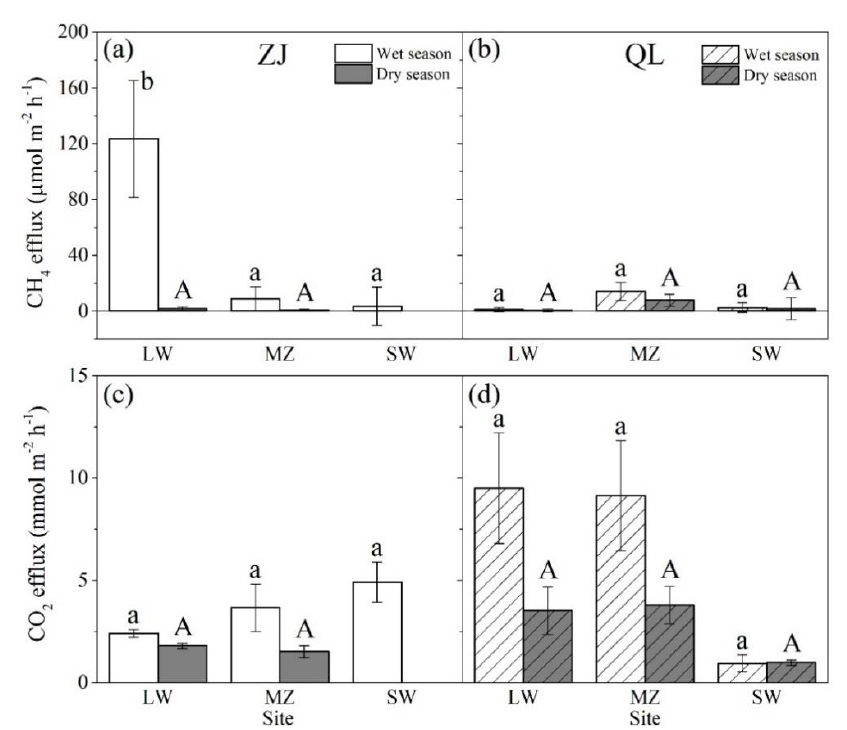
Figure 2. CH 4 and CO 2 effluxes from ZJ and QL mangrove soils. ( a , b ) Comparison of the mean soil CH 4 efflux among three tidal positions during wet and dry seasons at ZJ and QL site. ( c , d ) Comparison of the mean soil CO 2 efflux among three tidal positions during wet and dry seasons at ZJ and QL site. Error bars represent the standard error (SE) of the means ( n = 4). Different letters indicate significant differences among tidal positions for each period (wet and dry seasons) according to analysis of variance (ANOVA) test (Turkey HSD test, p < 0.05). Site abbreviations were the same as Figure 1.